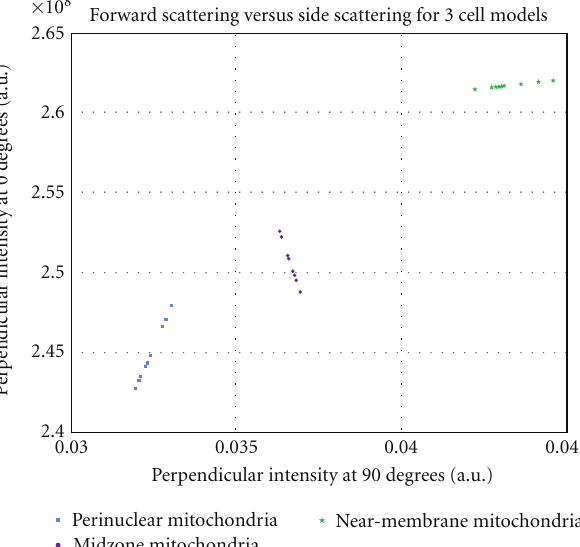
Figure 5: Side-scattering intensity i 2 for di ff erent mitochondria distributions. For each di ff erent distribution (represented by dif- ferent color) 10 realizations of the mitochondria positions were randomized to show the variance in scattering intensity.